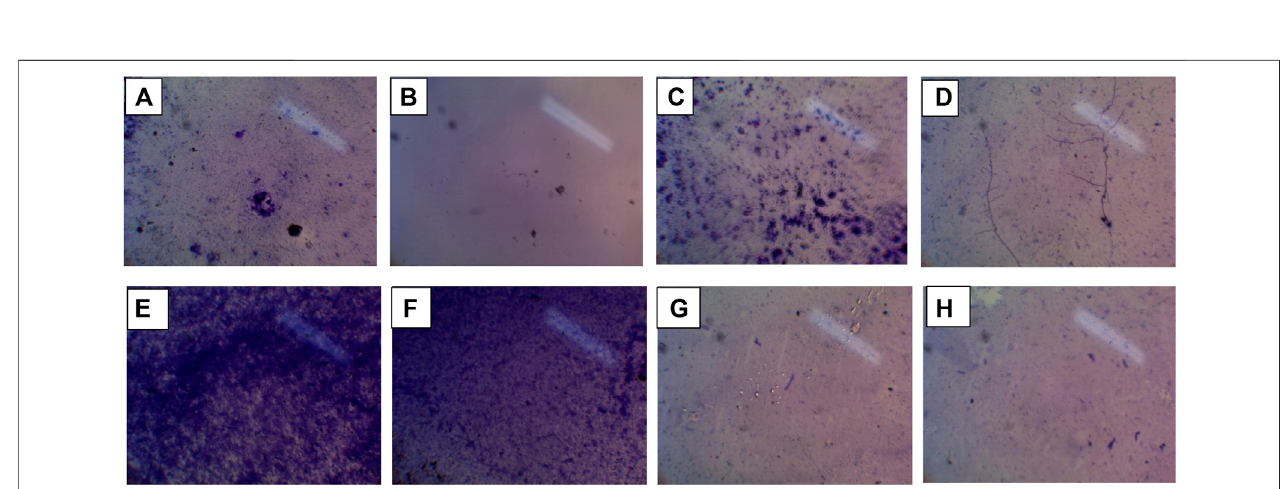
FIGURE 2 | Antibacterial activity of N. sativa extract and nanosuspension against Escherichia coli and Staphylococcus aureus isolates.